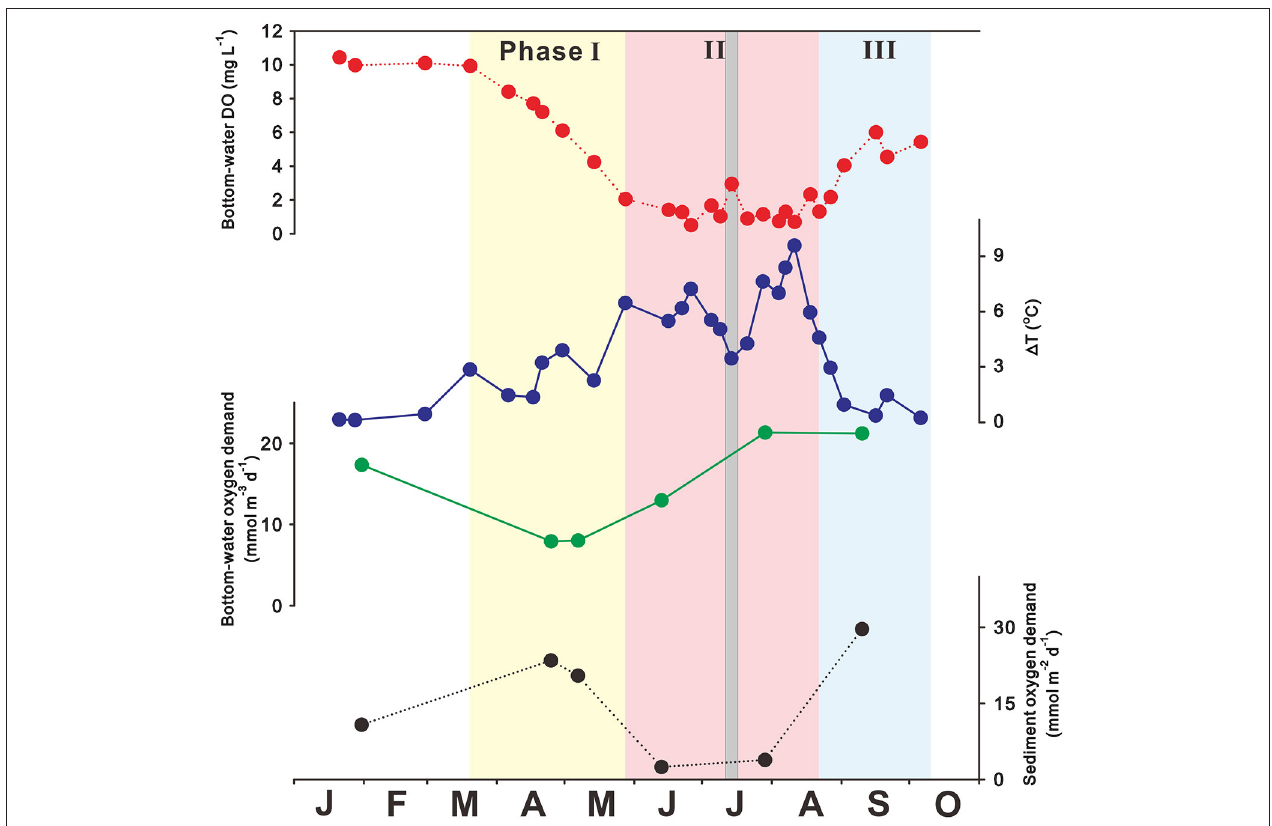
FIGURE 3 | Seasonal variation in bottom-water dissolved oxygen (DO; mg L − 1 ), 1 T (i.e., difference between surface and bottom temperatures; ◦ C), bottom-water oxygen demand (mmol m − 3 d − 1 ), and sediment oxygen demand (mmol m − 2 d − 1 ) observed in 2015 in Jinhae Bay. Phases I, II, and III encompass hypoxia development, persistence, and termination, respectively. The gray shading represents the Chan-Hom typhoon, which passed in July 2015. Source: Adapted from Lee et al. (2017) . Reproduced with permission of the Coastal Education and Research Foundation,